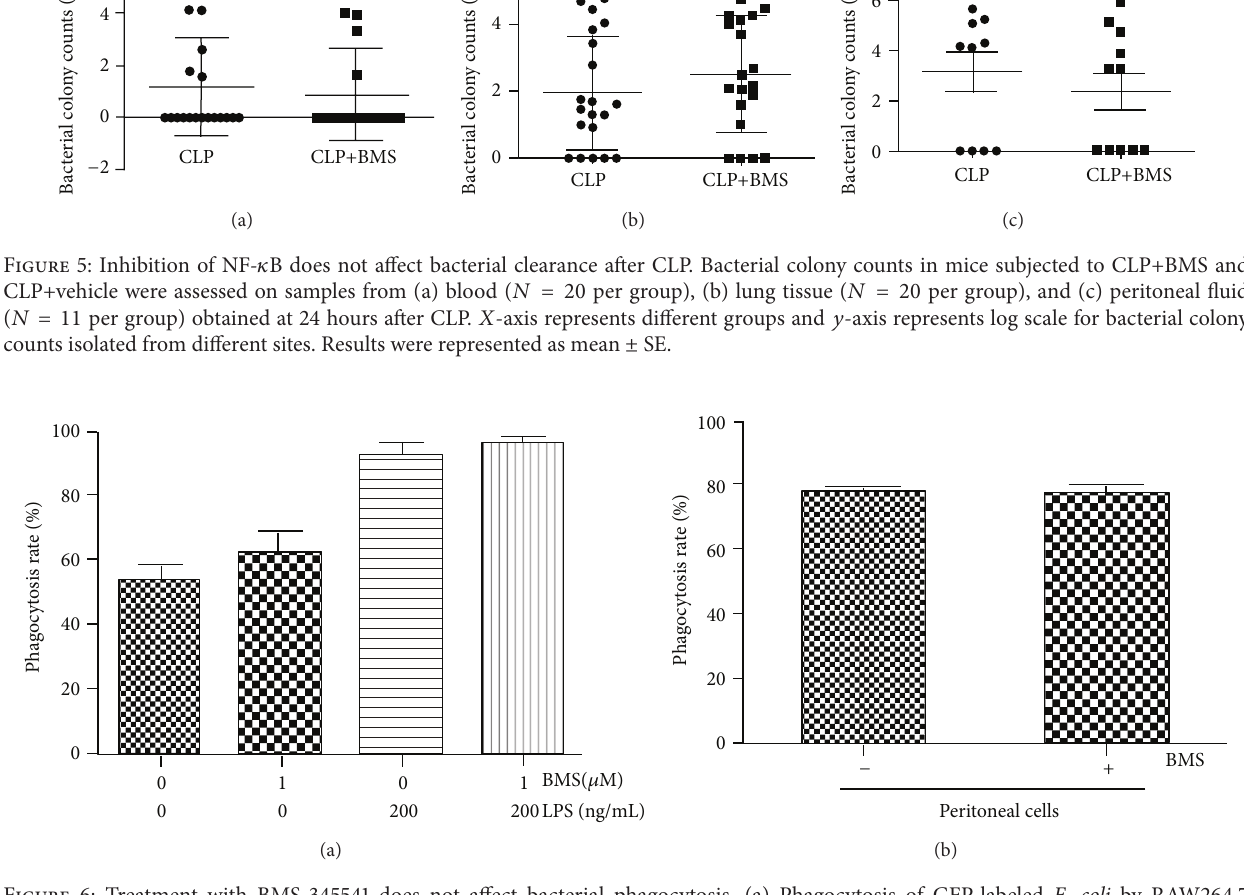
Figure 6: Treatment with BMS-345541 does not affect bacterial phagocytosis. (a) Phagocytosis of GFP-labeled E. coli by RAW264.7 macrophages was measured by counting fluorescent cells at 1 hour after adding bacteria. BMS-345541 and LPS were added to culture medium 1 hour prior to bacteria. (b) Cells were obtained by peritoneal lavage at 3 hours after CLP and bacterial phagocytosis was measured as described above. Results are presented as mean ± SE from 3 independent